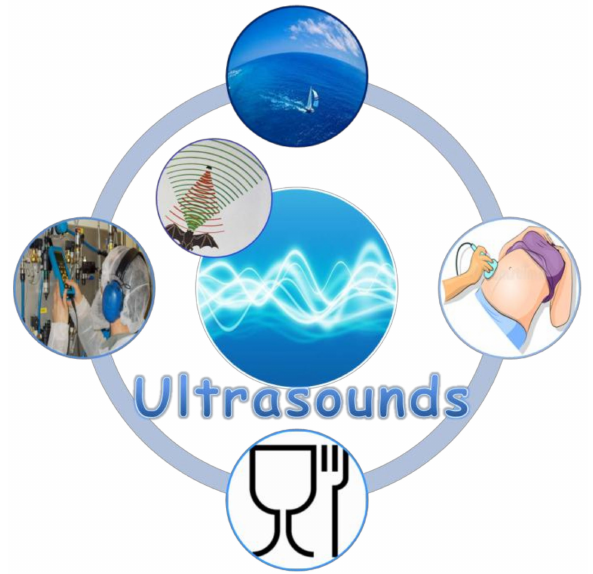
Figure 1. The different fields in which ultrasound (US) has been applied.